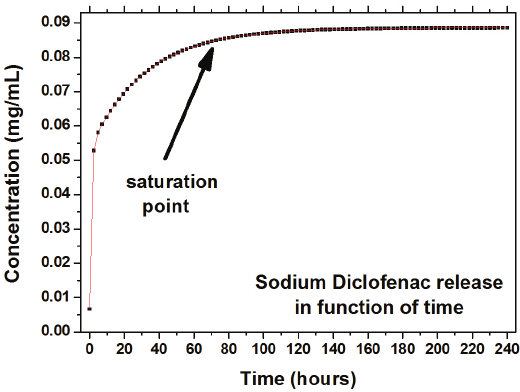
Figure 4. X-ray diffraction pattern of NRL (black line), sodium diclofenac powder (blue line), NRL membrane prepared with 3 mg.mL −1 of sodium diclofenac (red